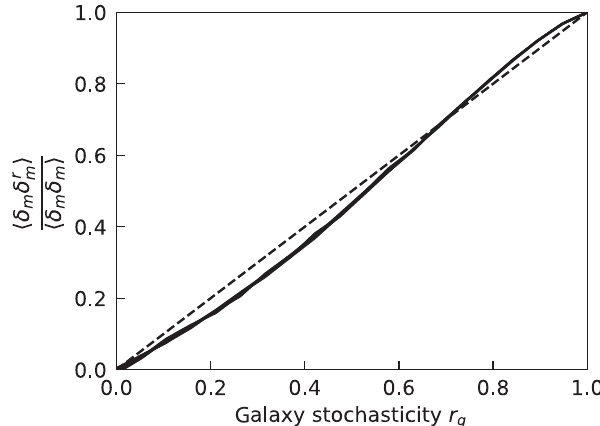
FIG. 8. Stochasticity parameter r corresponding cross-correlation between the galaxy density contrast δ and the underlying dark matter density field δ g